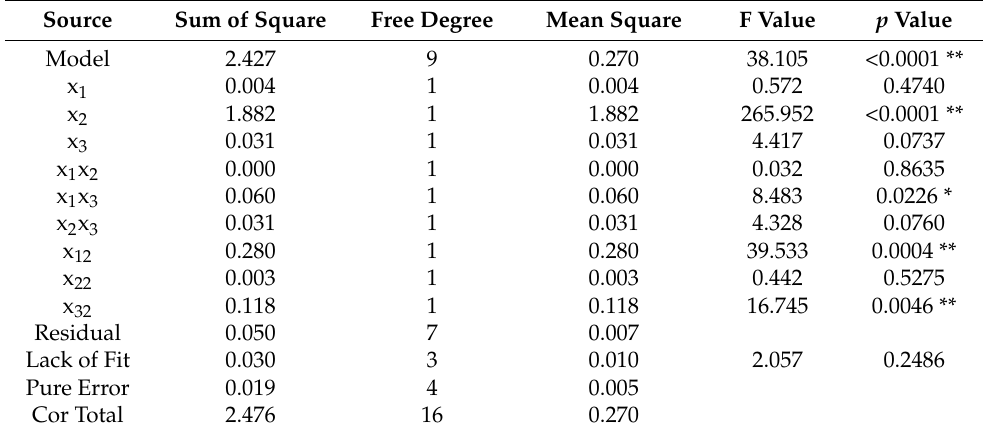
Table 4. Analysis of the grain loss rate regression Formula